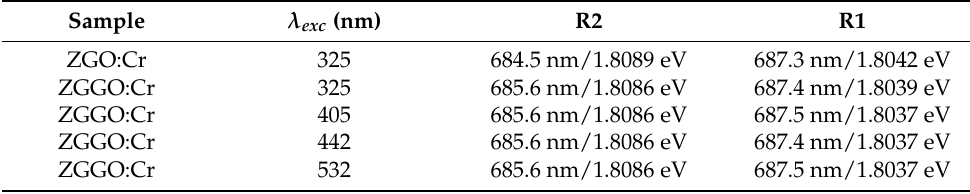
Table 2. Peak position of the R-lines for ZGO:Cr and ZGGO:Cr samples measured at 15